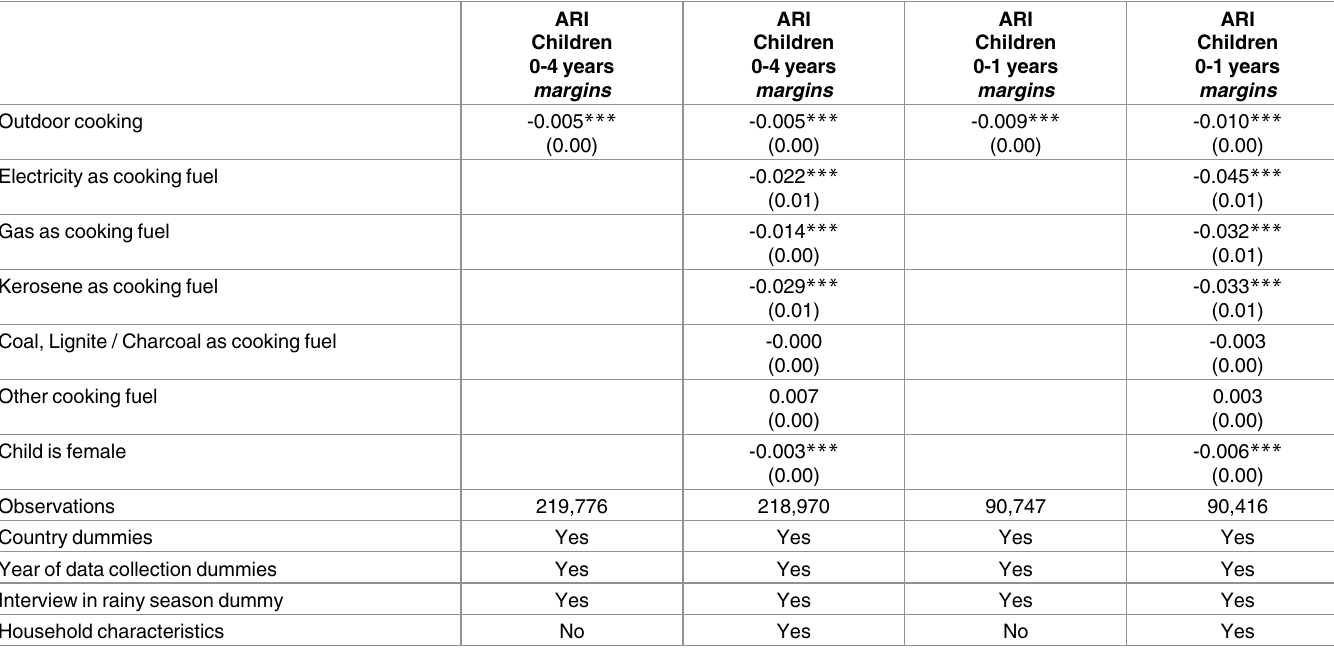
Table 1. ARI occurrence in rural areas (probit results) in the last two weeks preceding the survey a,b